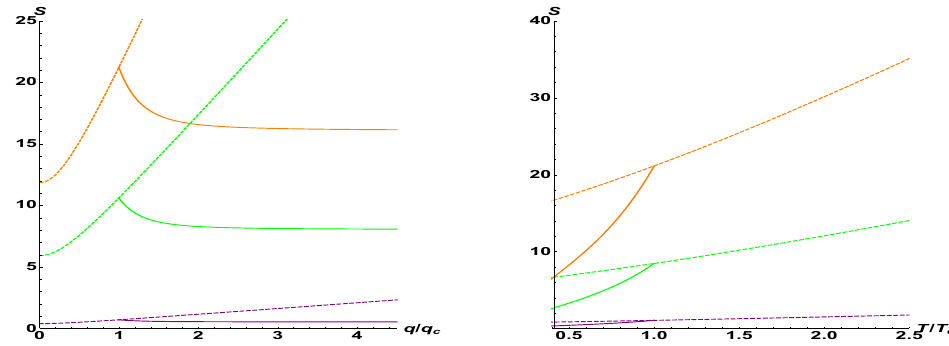
Figure 1 . w c normalized by q is plotted as a function of q c =q at the (cid:12)xed temperature T H = 0 : 15 with varying g 2 . The dashed line shows the analytic curve 1 : 18 YM is 21 : 7 T H and 33 : 5 T H for g 2 = 5 (cid:2) 10 (cid:0) 5 and 10, respectively. YM